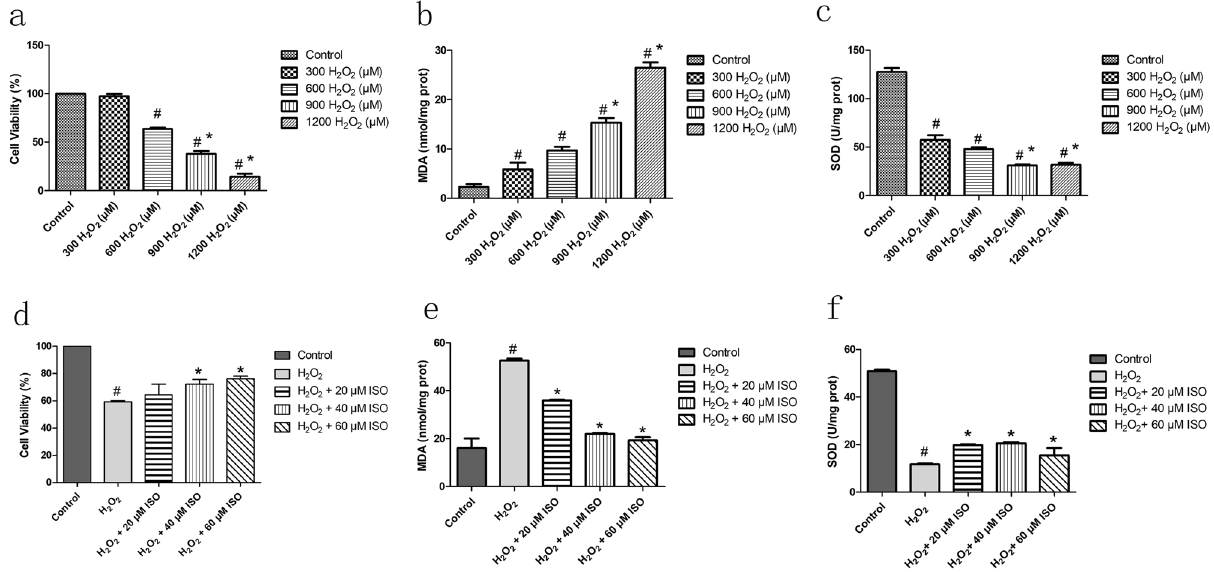
Figure 1. Effect of ISO on the cell viability, MDA content, and SOD enzyme activity after H 2 O 2 -treatment. The effect of H 2 O 2 on ( a ) the cell viability and ( b ) MDA content and ( c ) SOD enzyme activity in HaCaT cells. Control, untreated HaCaT cells; The experimental groups, cells were treated with a concentration 300, 600, 900, 1200 μmol/L of the experimental sample for 24 h. The effect of ISO on ( d ) the cell viability, ( e ) MDA content, and ( f ) SOD enzyme activity in HaCaT cells. Control, untreated HaCaT cells; H 2 O 2 -alone group, HaCaT cells treated with 600 μM H 2 O 2 ; all H 2 O 2 + cells were treated with ISO 600 μM H 2 O 2 . Graphs show the mean ± SD values of three replication. One-way analysis of variance (ANOVA) followed by Tukey’s post-hoc test. # indicates significant differences ( p < 0.05) from the control group. * indicates significant differences ( p < 0.05) from the treatment of HaCaT cells with 600 μM H 2 O 2